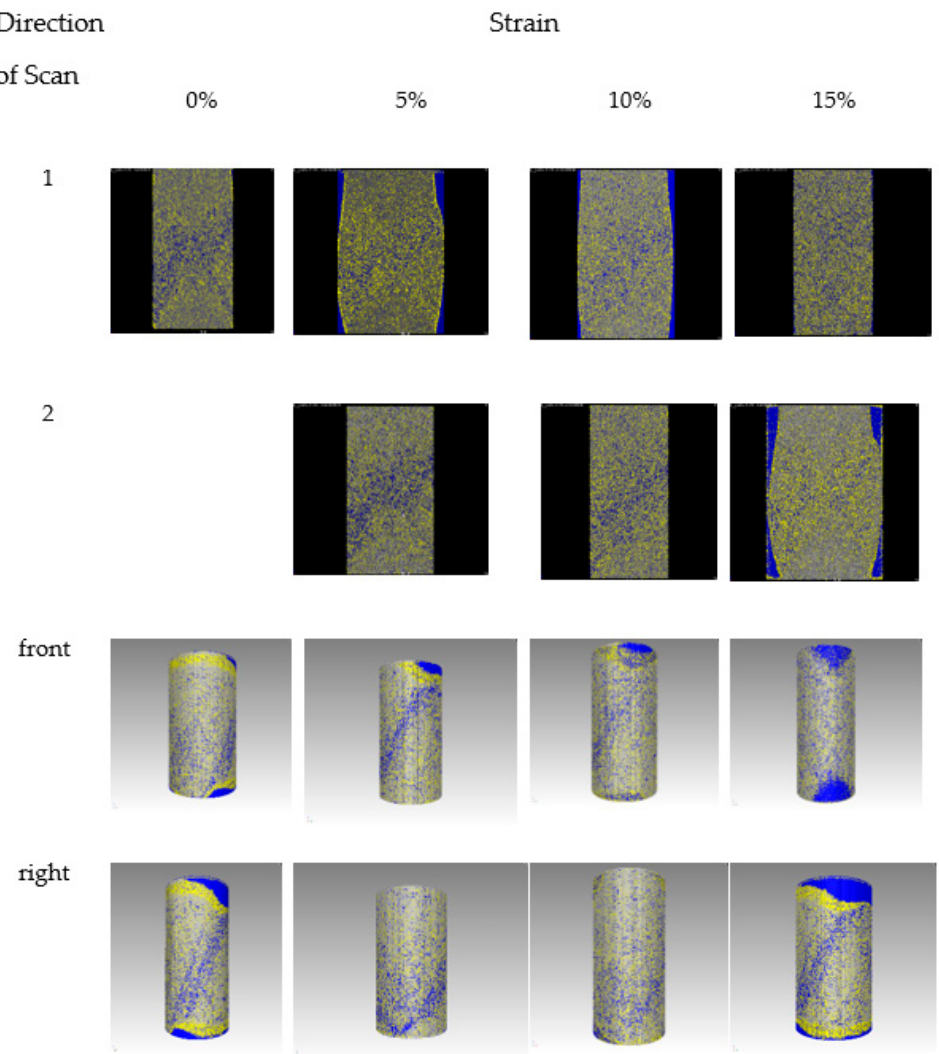
Figure 6. CT images with strain in different scan direction ( S h = 50%). Note: (1) This picture is a superposition of the information along the thickness of the samples; ‘front’/’right’ and ‘1’/‘2’ mean the different directions of CT scan to the samples; (2) The color of white indicates sand; the yellow indicates hydrate; the blue indicates gas.